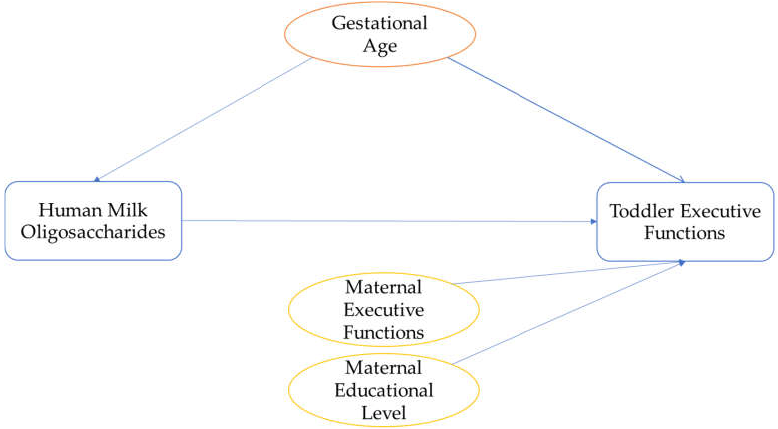
Figure 2. Directed Acyclic Graph for determining confounders. Blue colours represent the predictor and outcome variables. Orange represents the potential confounder related to both the predictor and the outcome, and yellow represents the potential confounder related to the outcome variable.